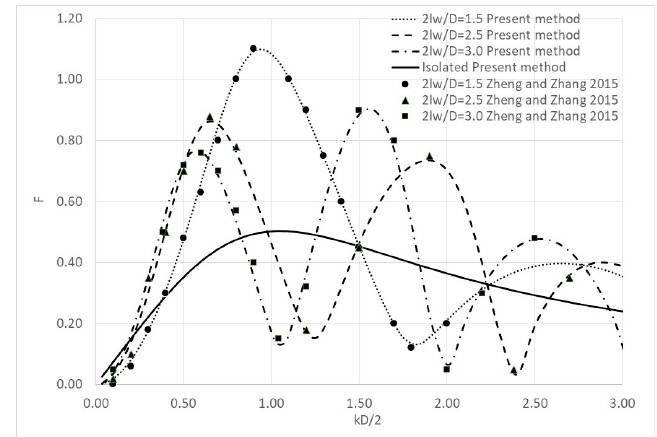
Figure 4. Dimensionless surge wave exciting forces against k D / 2 for three distances between the floater and the vertical wall and for an isolated floater (i.e., without the presence of the breakwater). The results are compared with the analytical results of [15]. J. Mar. Sci. Eng. 2020 , 8 , x FOR PEER REVIEW